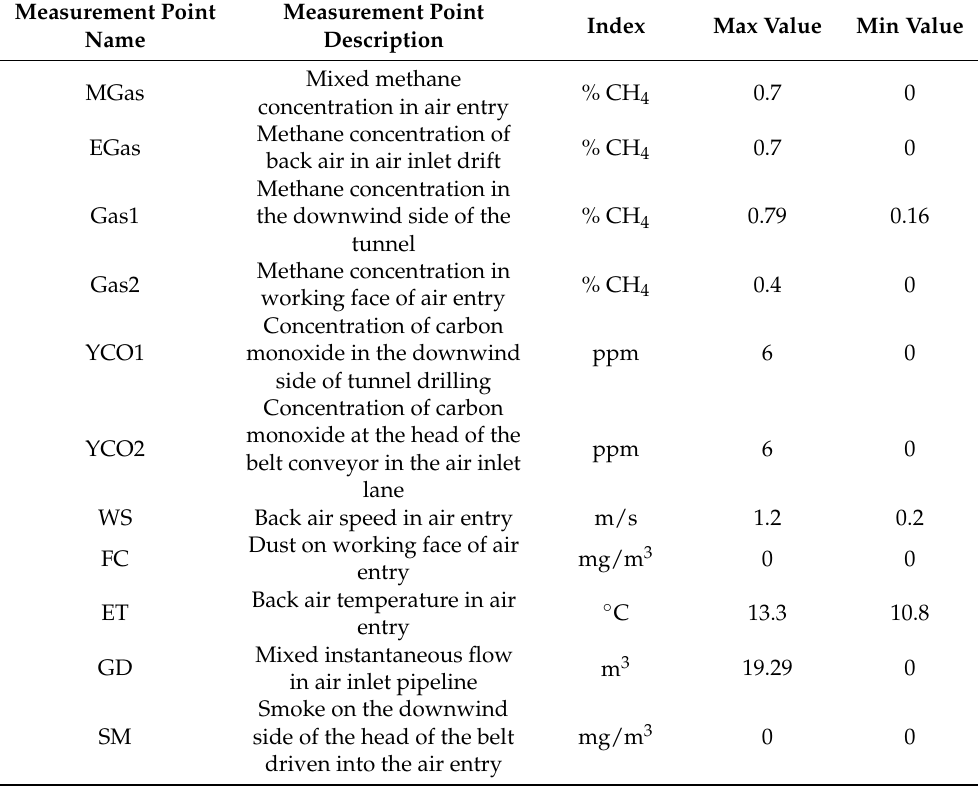
Table 1. Data attribute description of each measuring point at a working